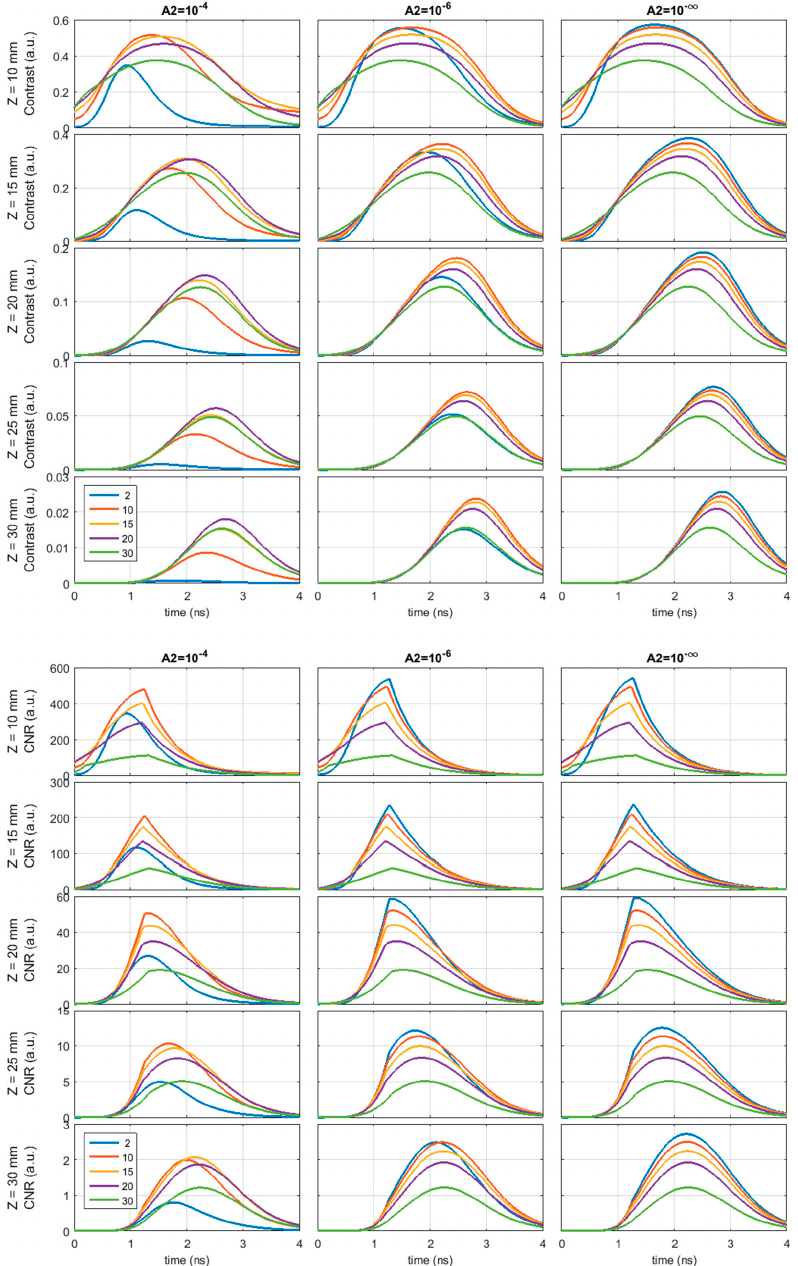
Figure 10. Contrast ( top panel group ) and contrast-to-noise ratio (CNR) ( bottom panel group ) produced by a localized absorption perturbation within a scattering medium (see Ref. [102] for additional details) as a function of the gate-ON delay of the SPAD. In each panel group, the perturbation is set at different depths along the rows, while along the columns different intensities of the memory effect are simulated. Different colors represent different source-detector distances, listed in the legend in mm.